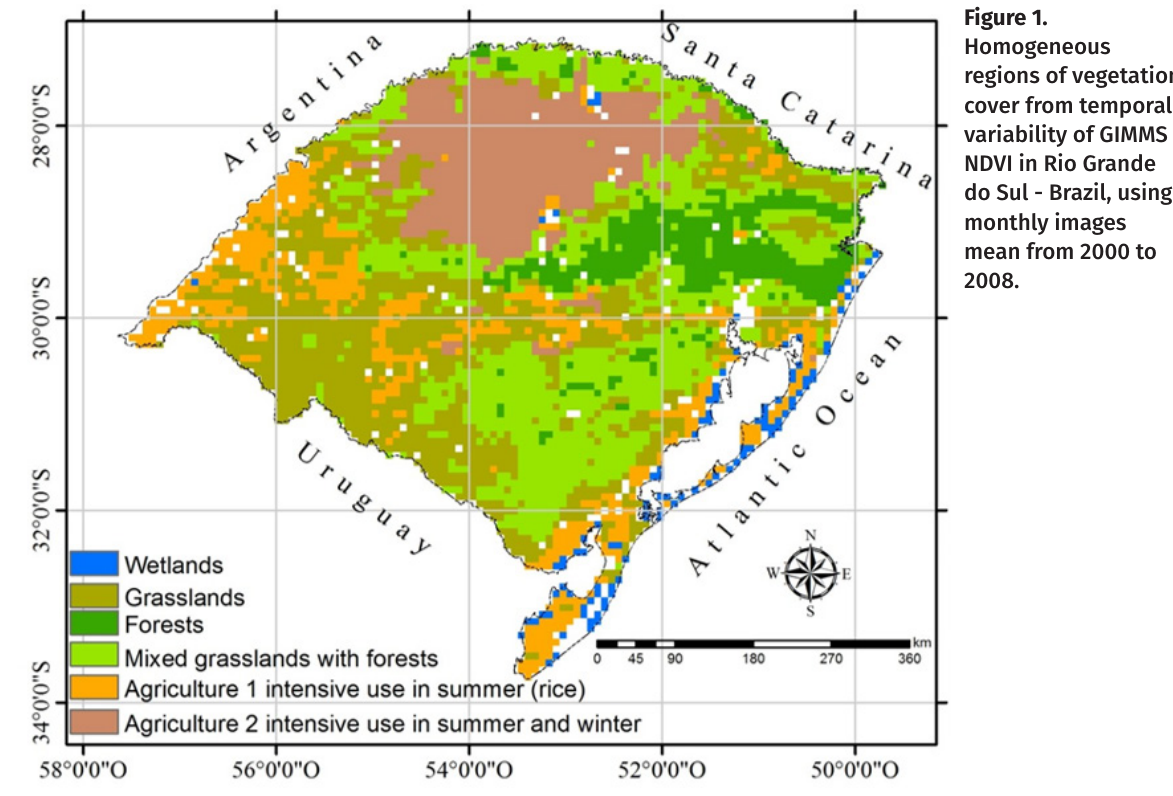
Figure 1. Homogeneous regions of vegetation cover from temporal variability of GIMMS NDVI in Rio Grande do Sul - Brazil, using monthly images mean from 2000 to